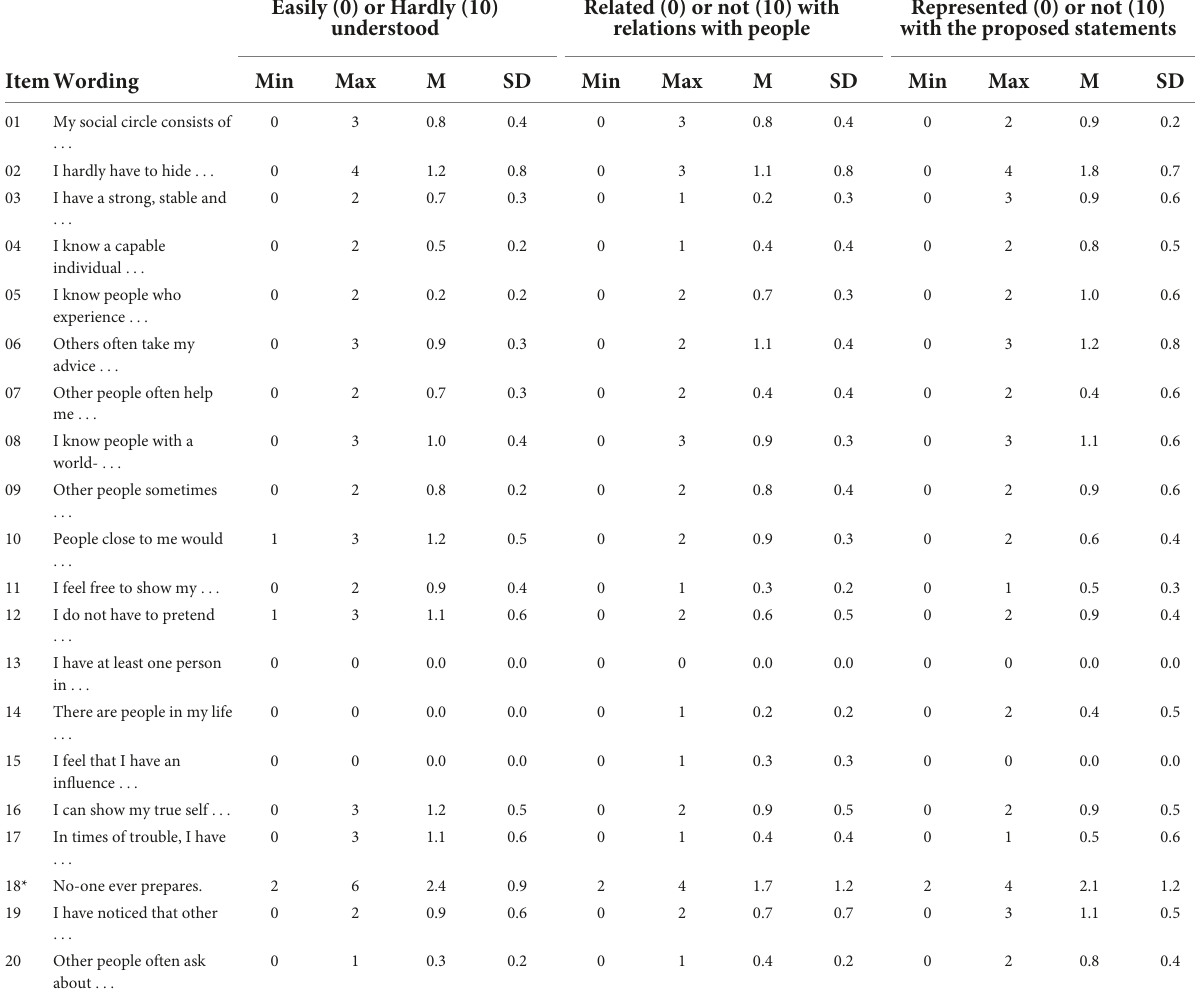
TABLE 1 Assessment of the understanding and adequacy of the items of the RNSS ( n = 10). Easily (0) or Hardly (10) Related (0) or not (10) with Represented (0) or not (10) understood relations with people with the proposed statements